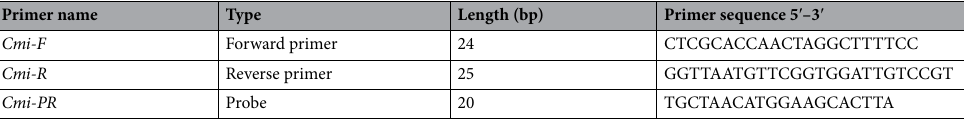
Table 3. Details of species-specific primers and the probe designed to amplify a 127 bp fragment of the 16S region of Channa micropeltes (Cuvier,